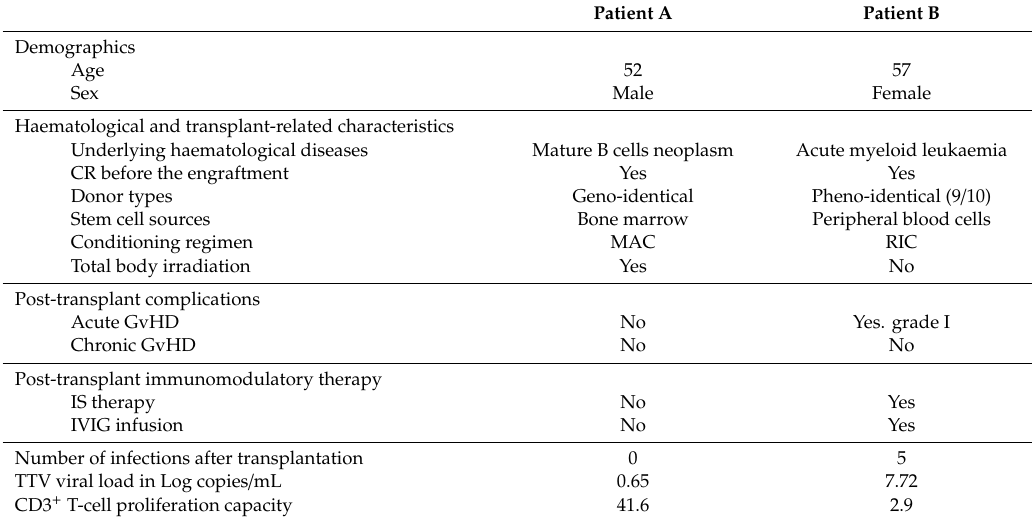
Table 2. Clinical characteristics of patients with extreme values of TTV viral